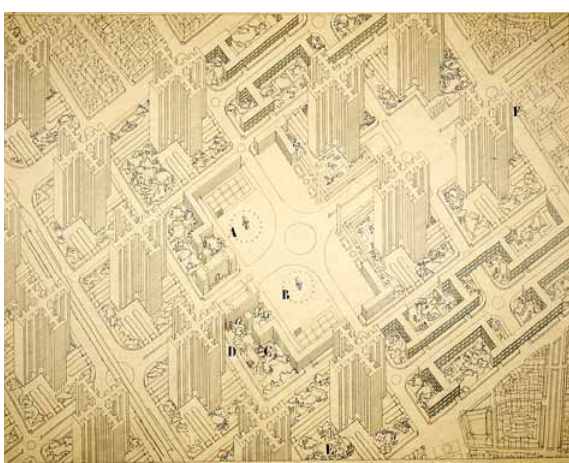
fig. 17. Sketch for axonometric view. flC29723 © flC-aDaGP